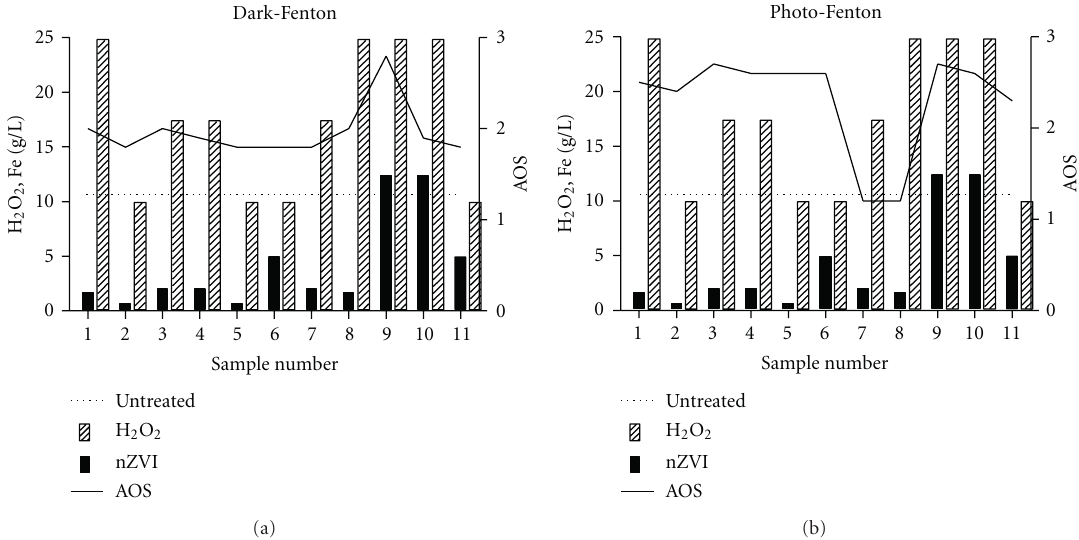
Figure 5: Amounts of reagents (g/L) and the AOS values obtained after each